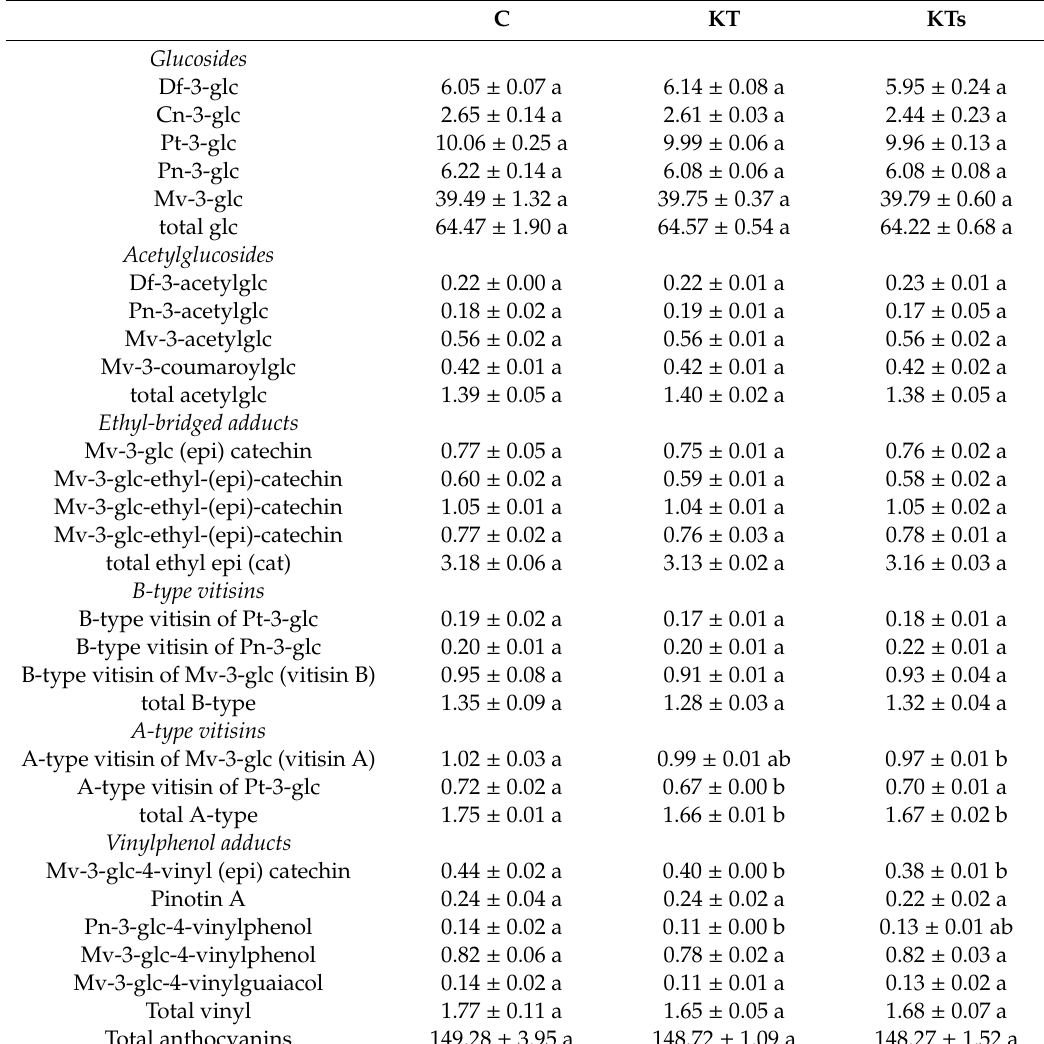
Table 4. Anthocyanins content of wines after 7 days of treatment with chitosan. In the same row, di ff erent letters indicate significant di ff erences according to Tukey’s test ( p < 0.05). n = 3. C: no addition; KT: 0.5 g / L of solid chitosan; KTS: 0.5 g / L of chitosan in